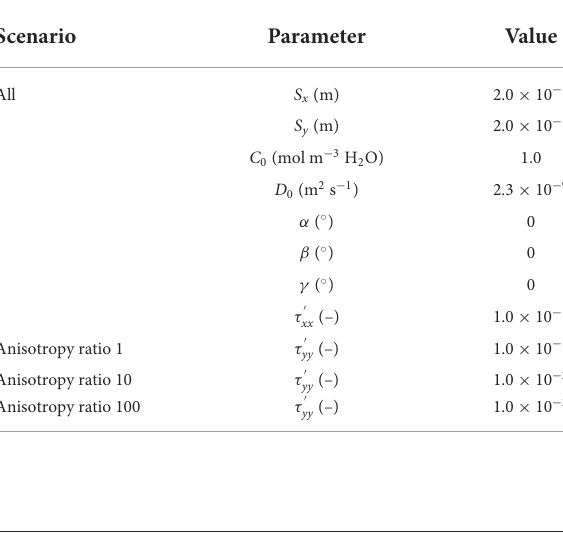
TABLE 1 Model parameters for 2-D anisotropic diffusion verification problem.